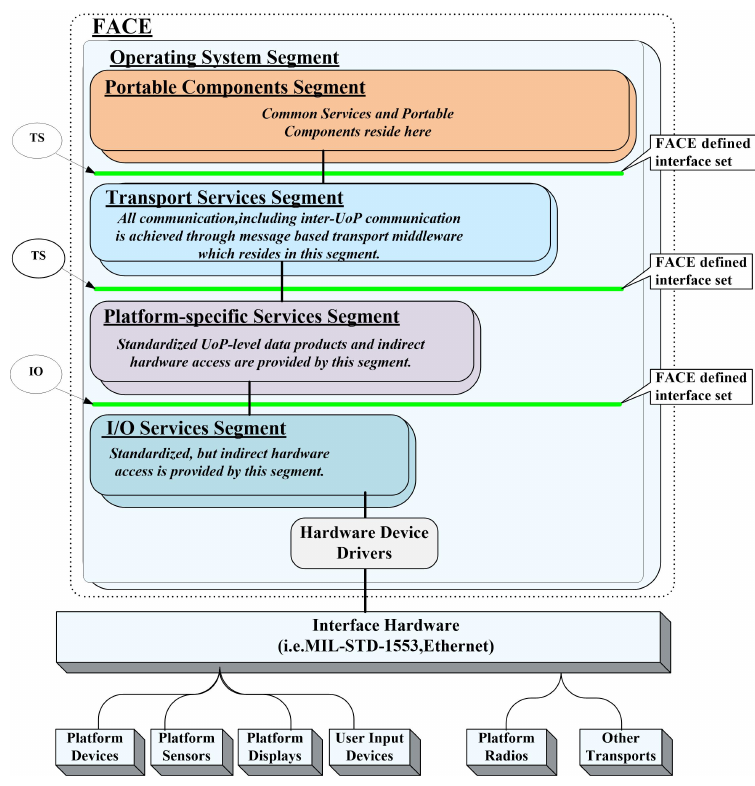
Figure 1. The FACE